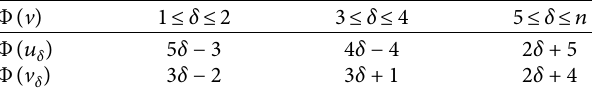
Table 15: Vertex labeling of Φ ( v ).